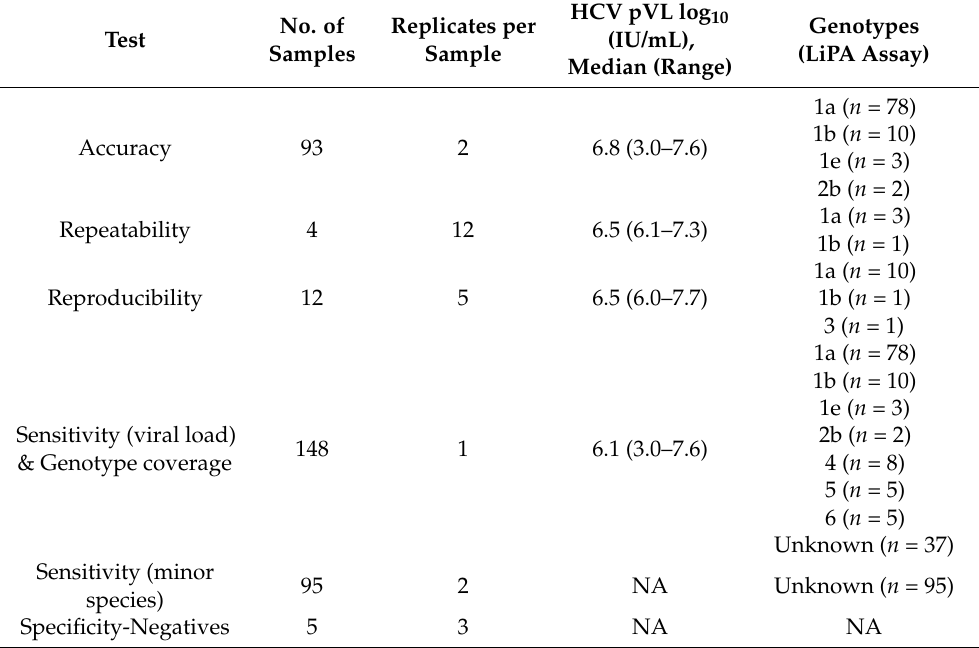
Table 1. Specimen characteristics for assessing individual assay validation